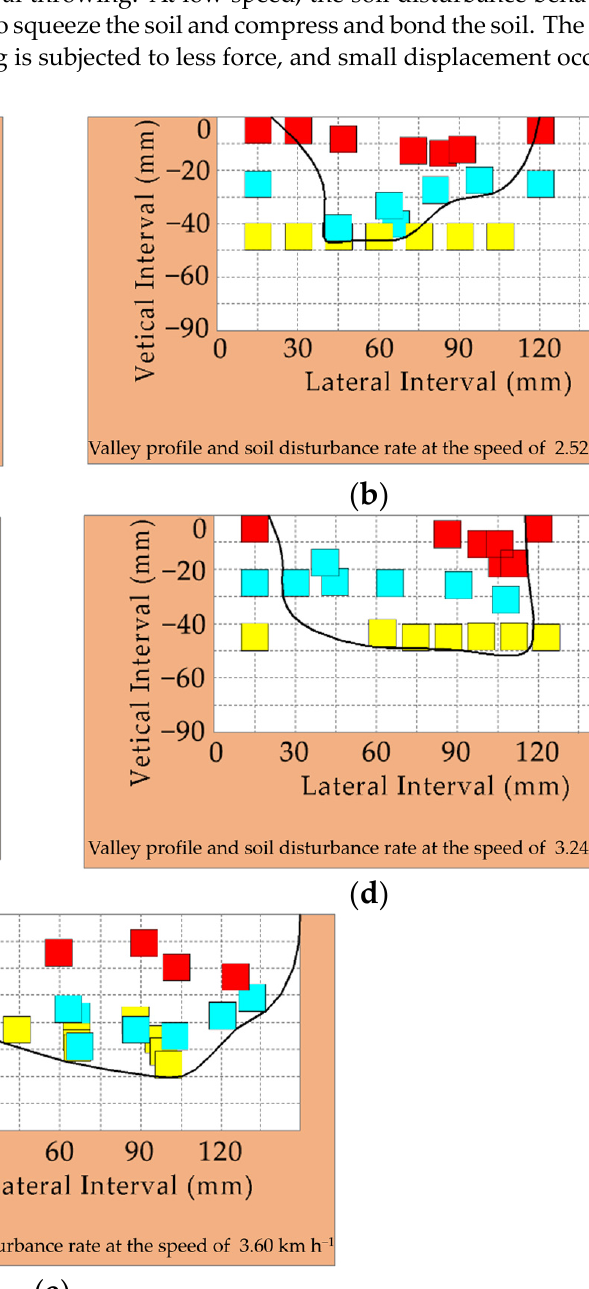
− 1 − 1 and 3.24 km h , and